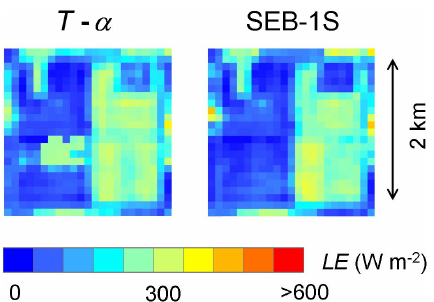
Fig. 10. Images on 6 May 2008 of the ET simulated by the classical T − α space-based model and SEB-1S over a sub-area of the study